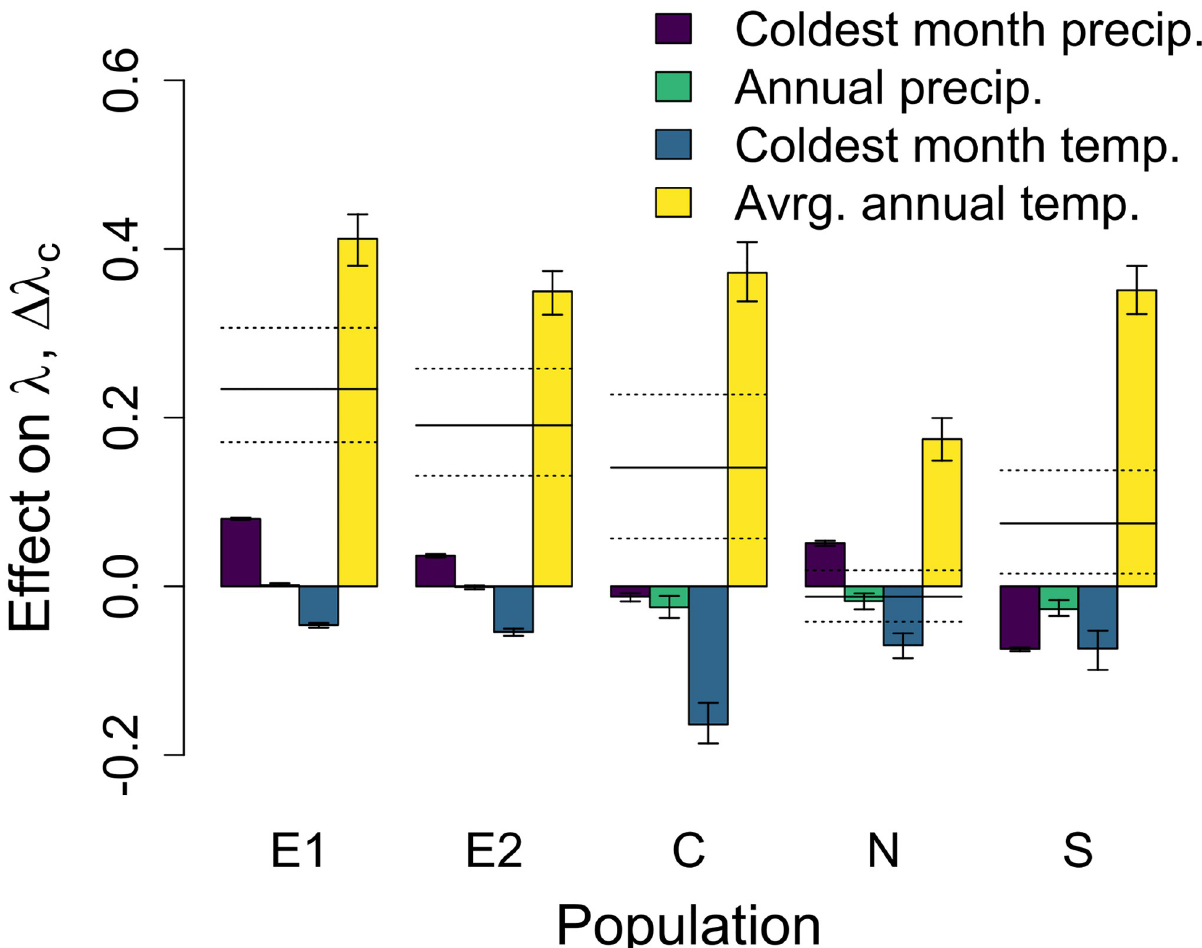
Fig 8. Δλ c , the effect of each climate variable on the change in population growth rate. We show Δλ c , calculated for each climate variable changing current (2008–2022) climate variables to future (2084–2099) climate variables, one climate variable at a time. Bars indicate the mean Δλ c and error bars indicate the 95% confidence intervals of Δλ c s, calculated across bootstrapped parameter estimates. Horizontal lines indicate the mean Δλ , future- current population growth rate, and dotted lines indicate the 95% confidence intervals of Δλ , calculated across bootstrapped parameter estimates. In both panels, populations are arranged in the same order as in prior figures (increasing current average annual